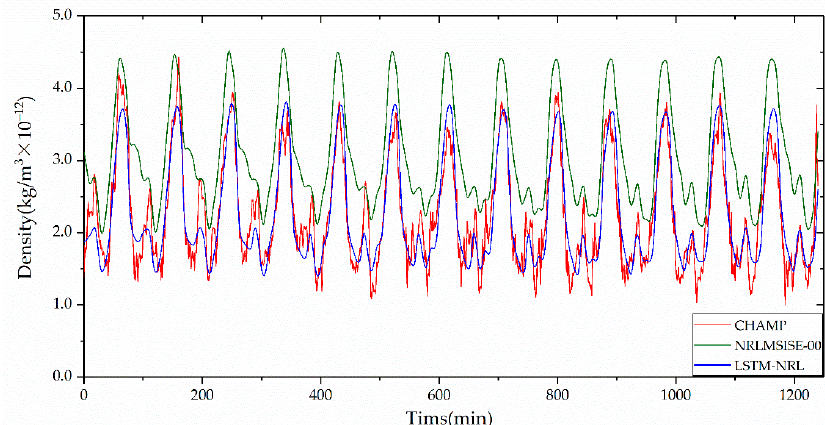
Figure 6. The three density series on day 30 of 2007, Test 4.